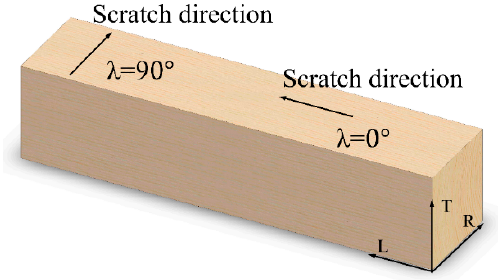
Figure 3. Schematic diagram of scratch direction and wood grain direction.